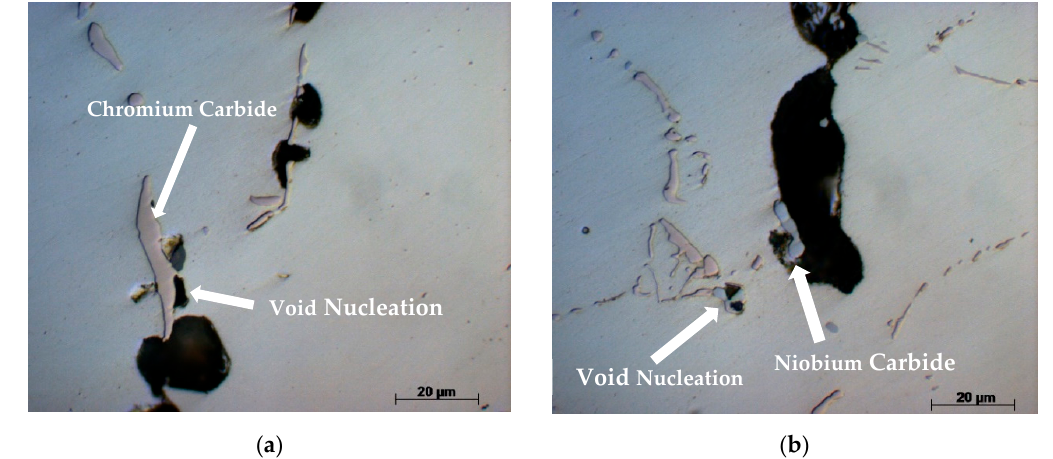
Figure 5. Void nucleation on ( a ) chromium carbide and ( b ) niobium carbide particles.